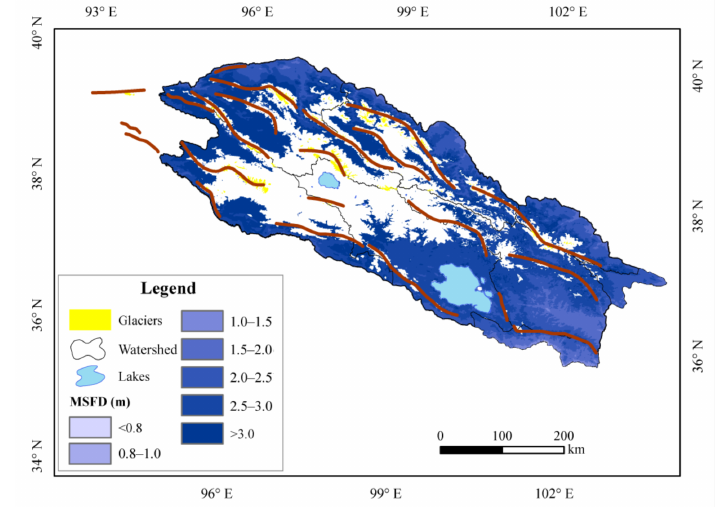
Figure 8. Spatial distribution of maximum frozen soil depth (MFSD, m) in the Qilian Mountains. Unlike the trend of regional average ALT, the MFSD in the QLMs averaged over 2004–2019 showed a decreasing trend (Figure 9). The average MFSD was 2.68 ± 0.48 m, 2.57 ± 0.49 m, 2.58 ± 0.44 m, and 2.58 ± 0.48 m during 2004–2005, 2006–2010, 2011–2015, and 2016–2019, respectively.